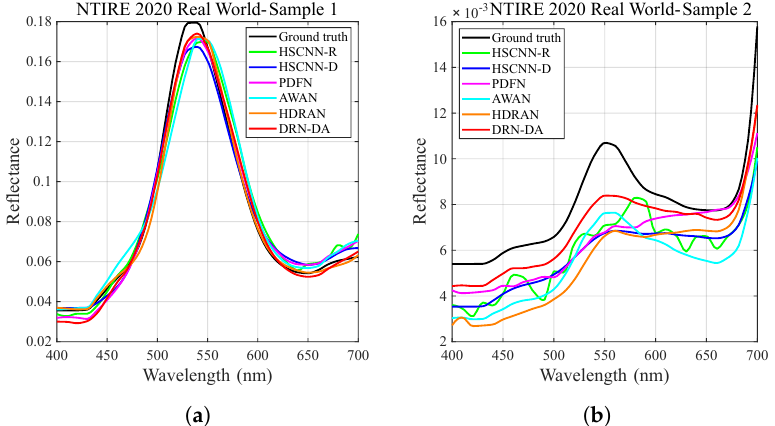
Figure 14. Spectral reflectance of selected samples from the NTIRE 2020 “Real World” track. ( a ) Sam- ple 1. ( b ) Sample 2.